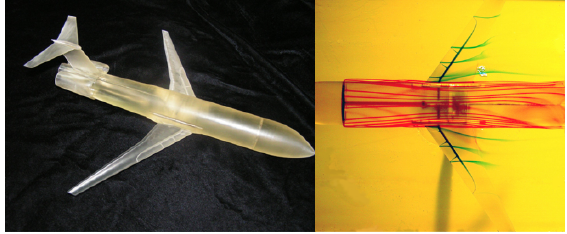
Figure 1. SLA model for flow study and visualization of flows in